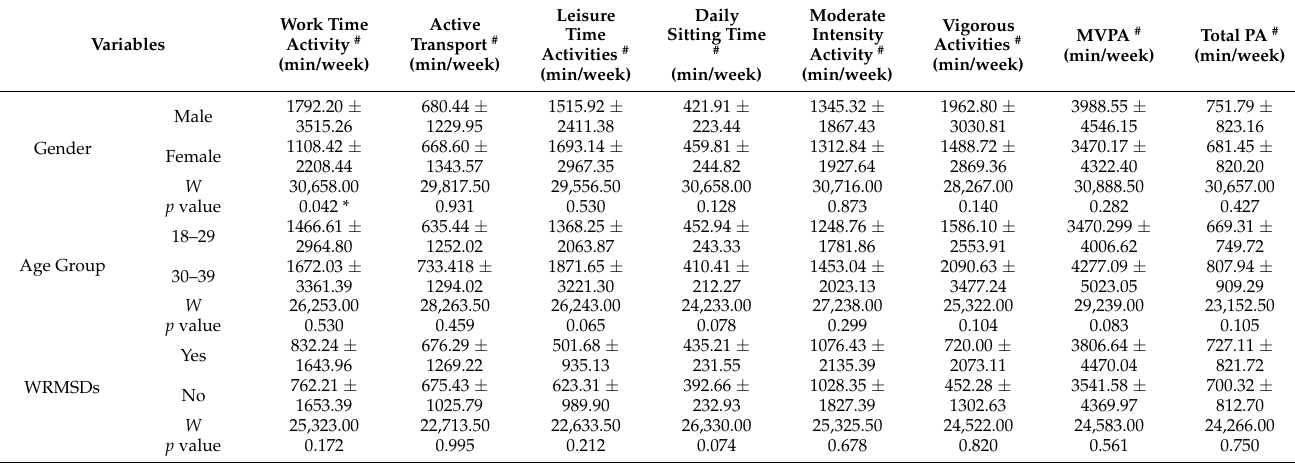
Table 2. Results of the GPAQ domains by gender and musculoskeletal conditions.